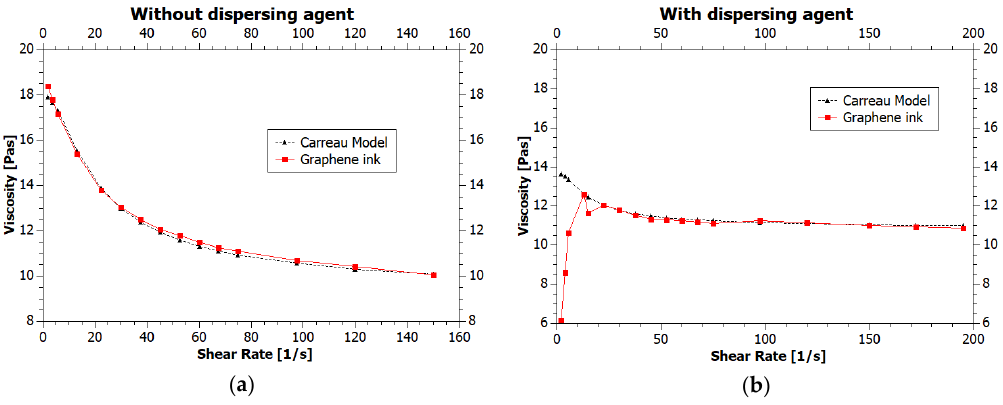
Figure 5. Graphene viscosity curves with fitted Carreau Model curve ( a ) graphene ink without dispersing agent; ( b ) graphene ink with dispersing agent.